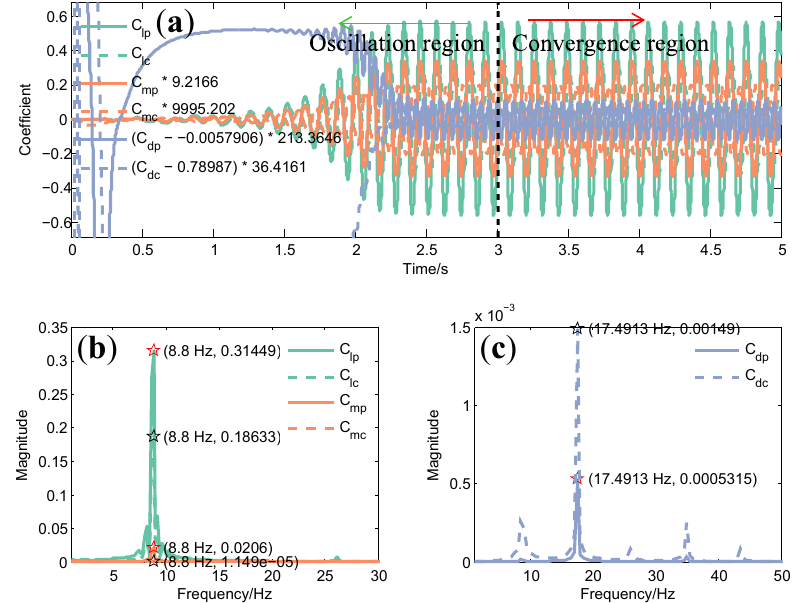
Figure 5. ( a ) The time history of coefficients of instantaneous forces, ( b ) the frequency spectra of C lp , C lc , C mp , C mc and ( c ) C dp , C dc for the simulation of U = 1.5 m/s and L ∗ =